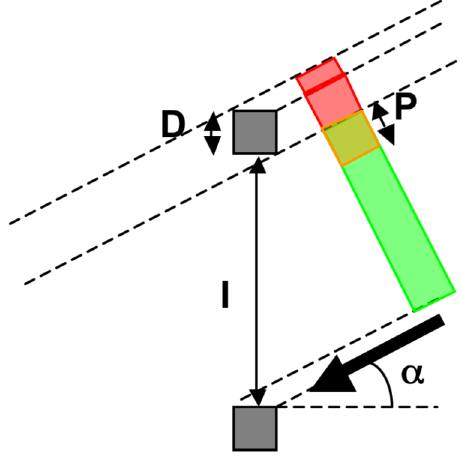
Figure A3. Geometric analysis for the square bar armour system.